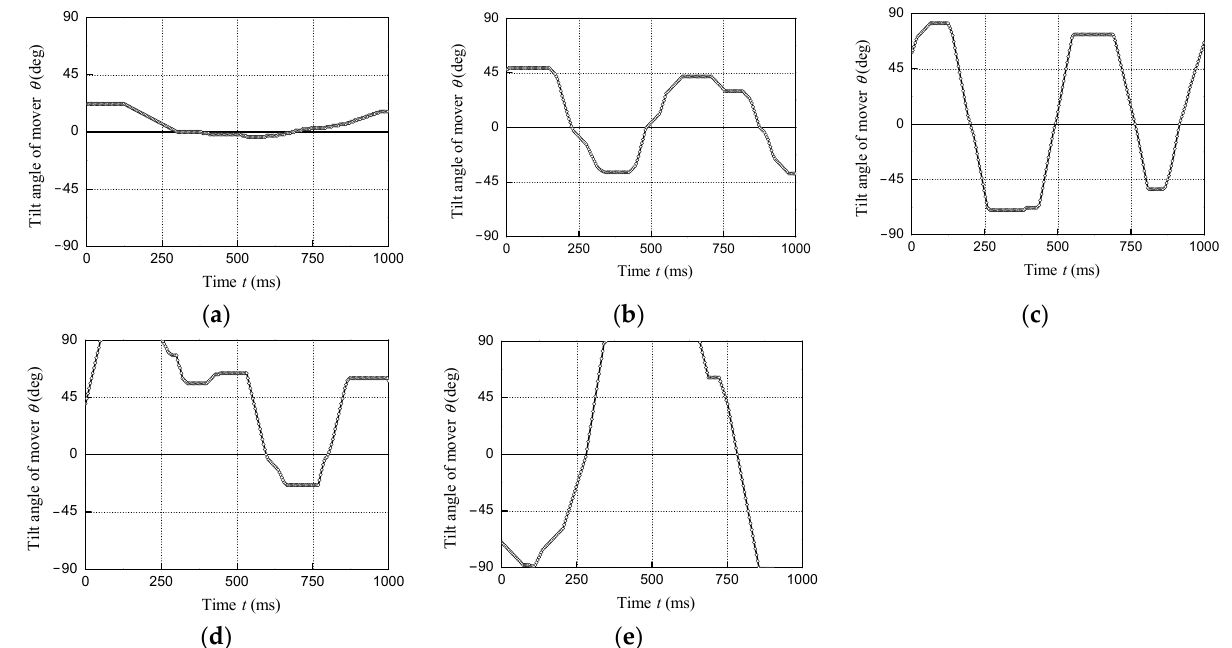
Figure 12. Vibration-experiment result at θ m = 0°. ( a ) f i = 1.0 Hz; ( b ) f i = 1.5 Hz; ( c ) f i = 2.0 Hz; ( d ) f i = 2.5 Hz; ( e ) f i = 3.0 Hz.